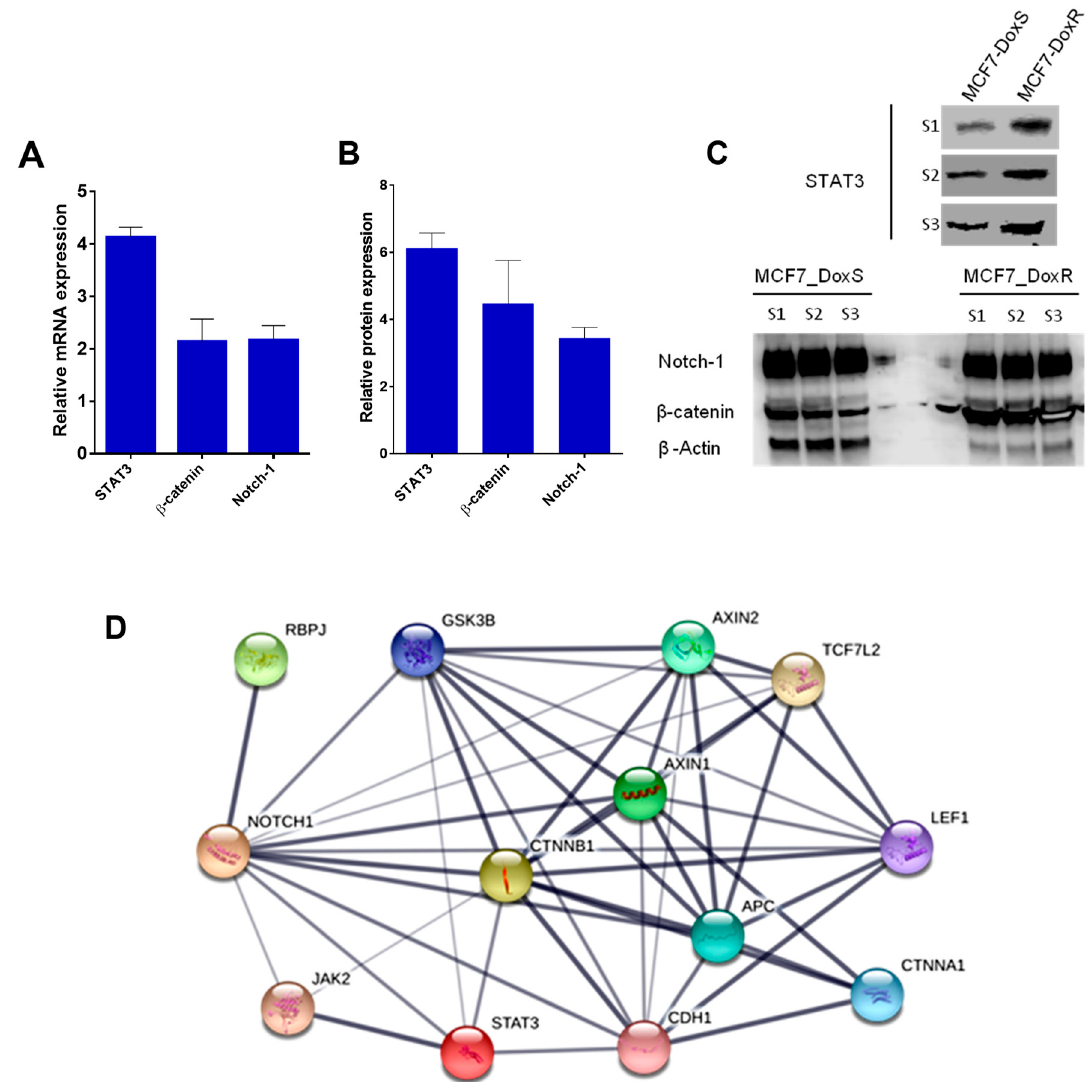
Figure 3. Expression of targeted genes. ( A ) The fold change in the mRNA expression of STAT3, β -catenin, and Notch-1 in MCF7_DoxR cells compared to the MCF7_DoxS cells (the 18srRNA gene was used as a housekeeping gene for Q-PCR). ( B ) The fold change in the protein expression of STAT3, β -catenin, and Notch-1 in MCF7_DoxR cells compared to the MCF7_DoxS cells. ( C ) The expression of STAT3, β -catenin, and Notch-1 proteins analyzed by WB (S1, S2, and S3 stands for three different samples). ( D ) STRING analysis of protein–protein interactions of the STAT3, β -catenin, and Notch-1 proteins, upregulated in MCF7_DoxR cells compared with MCF7_DoxS cells (thickness of edges indicates confidence) [39]. Data represent the average of three independent experiments ± SD.